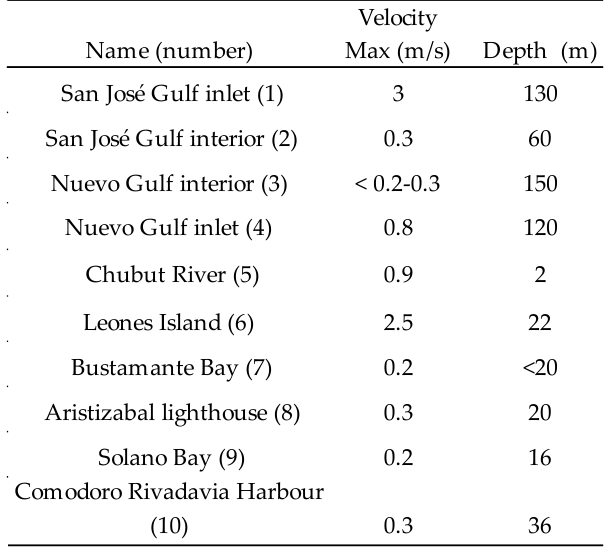
R EFERENCES OF F IG . 1. S ITES ON THE C HUBUT COAST WITH TIDAL CURRENT VELOCITY AND DEPTH .